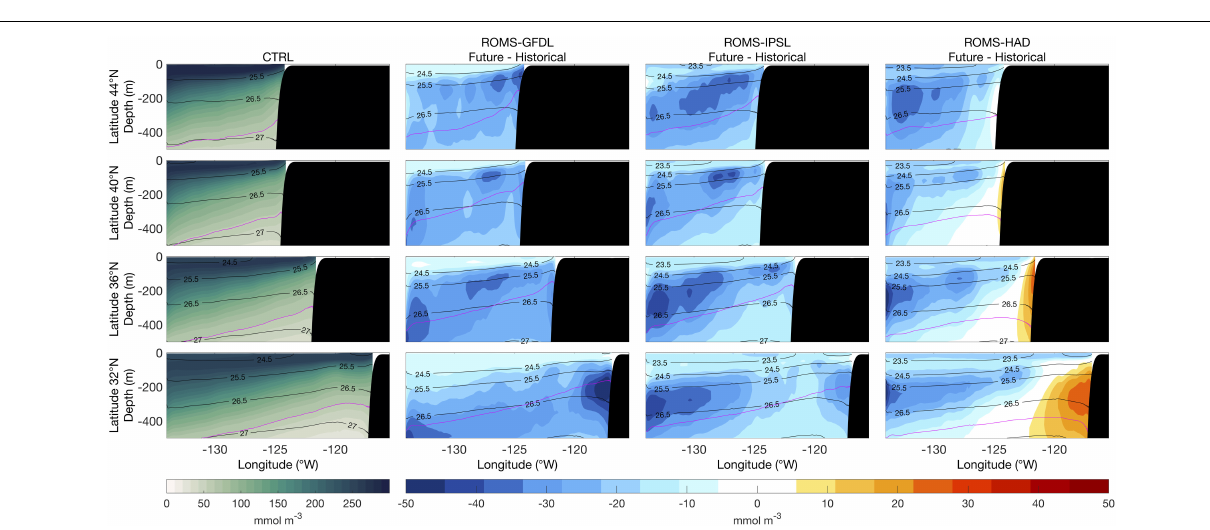
FIGURE 7 | Vertical sections of mean dissolved oxygen (1980–2010) from the control run (CTRL, first column) and of future nitrate changes (2070–2100 relative to historical) from the high-resolution downscaled projections: ROMS-GFDL (second column), ROMS-IPSL (third column), and ROMS-HAD (fourth column). Black contours are potential density (kg m − 3 ) relative to sea surface. Magenta contour corresponds to the hypoxic boundary layer (1.43 ml/l or 63.86 mmol/m 3 O 2